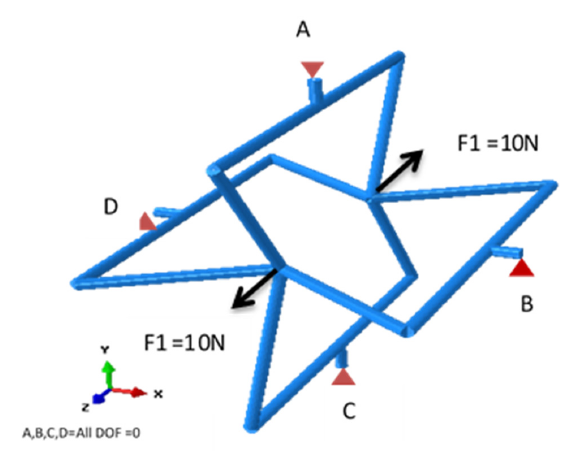
Figure 2. The applied forces and boundary conditions induced on the rendered beam structure.